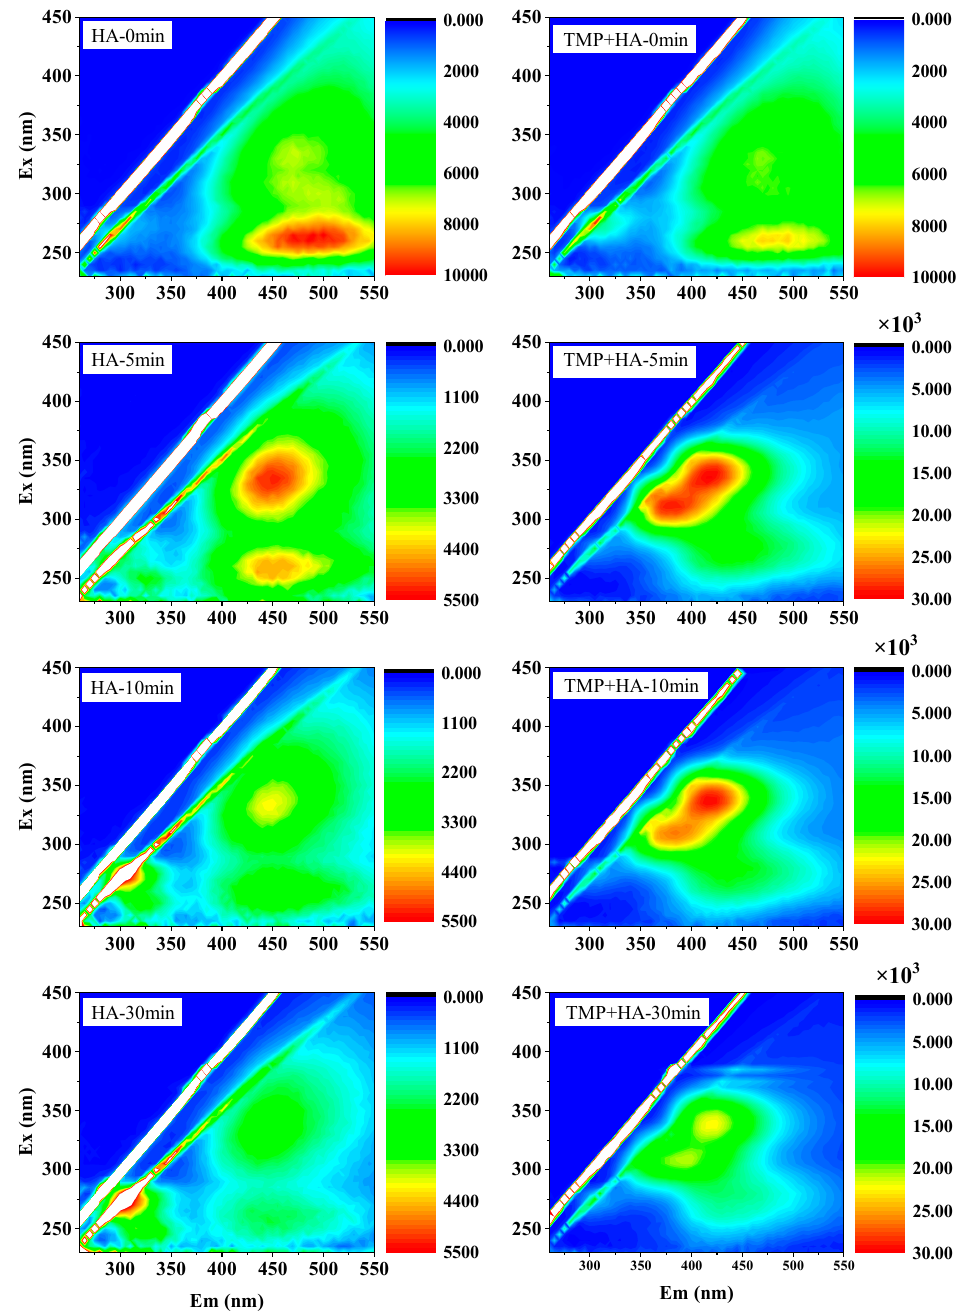
Figure 7. 3D-EEM analysis of ozonation of humic acids (HA) solution and TMP solution added with HA.